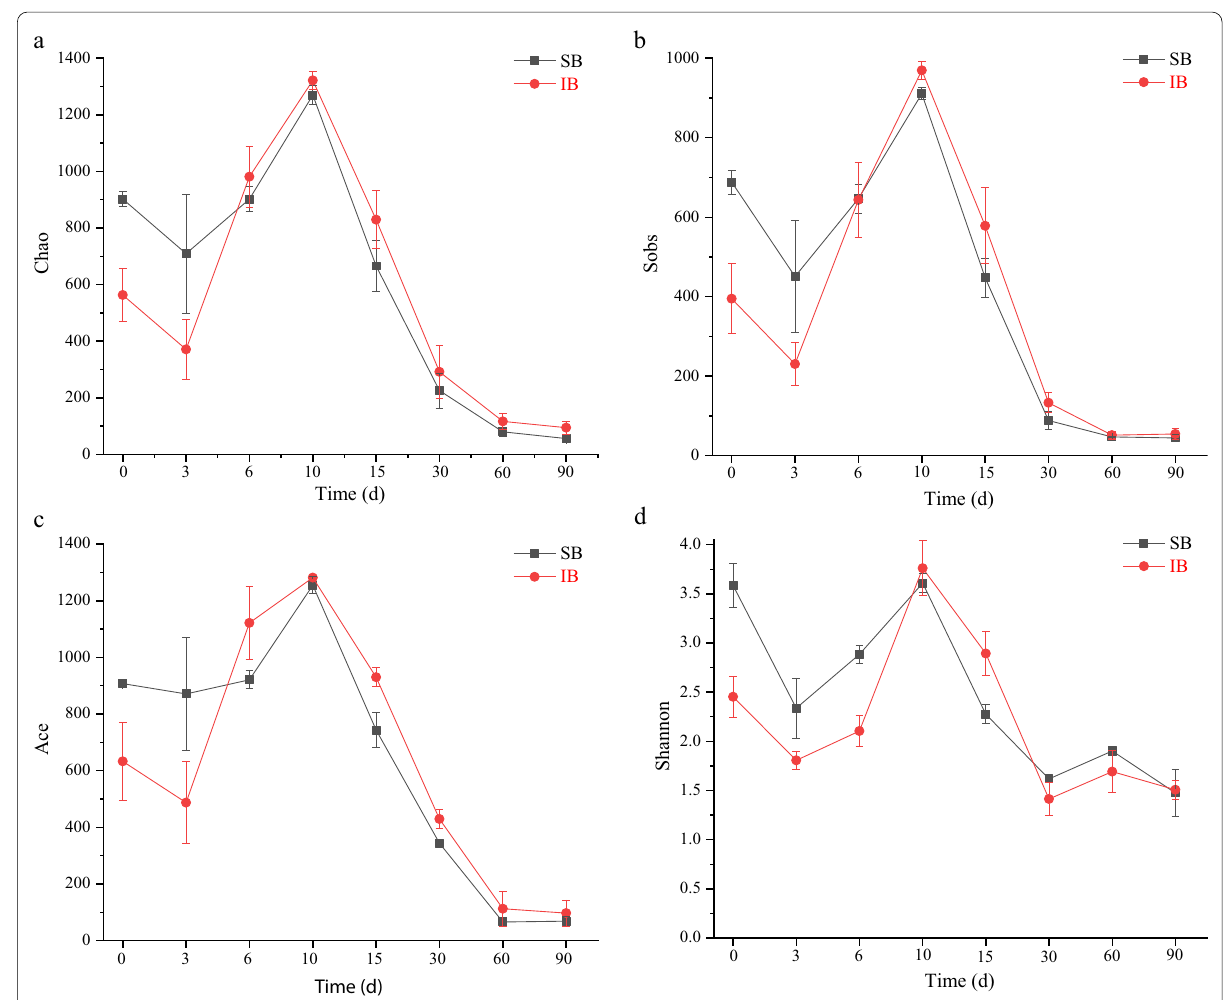
Fig. 1 Alpha diversity of wet-salted goatskin microorganisms at different time under Chao ( a ), Sobs ( b ), Ace ( c ) and Shannon ( d )